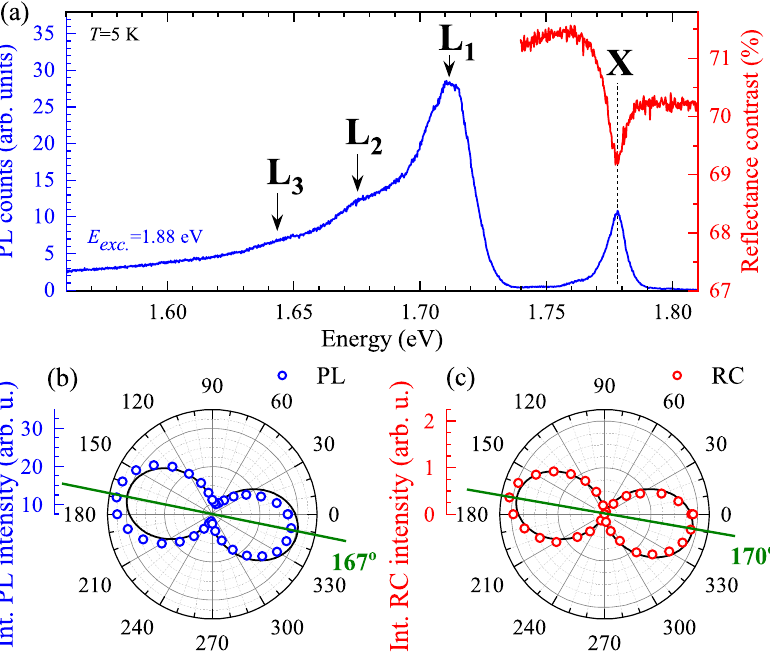
Figure 2. ( a ) The low-temperature ( T = 5 K) PL (blue curve) and RC (red curve) spectra measured on the GeS flake. Polar plots of the integrated intensities of the X transitions from the ( b ) PL and ( c ) RC